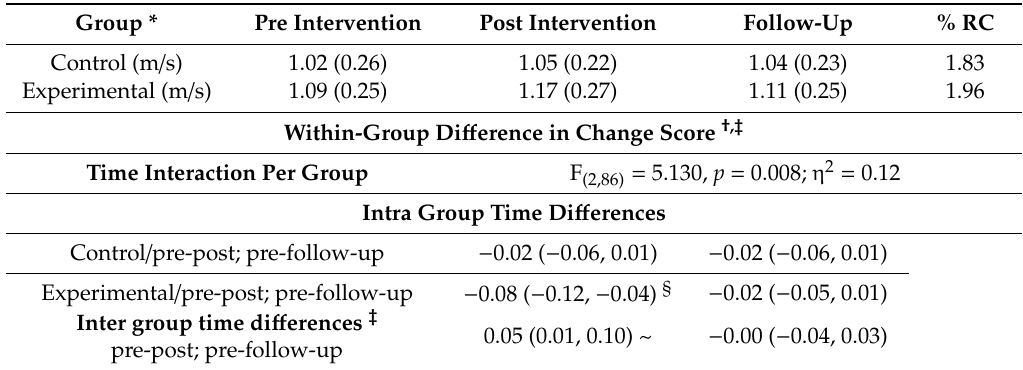
Table 4. Speed intra- and inter-group di ff erences.